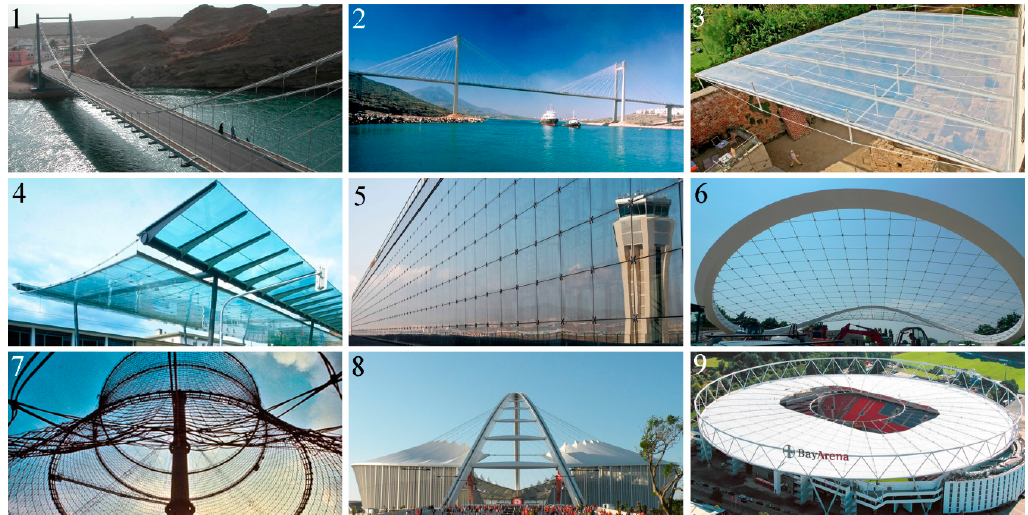
Figure 1. Typical modern cable structures with steel cables: ( 1 ) suspension bridge, Highway Bridge Khor al Batah, Oman (photo credit: STRABAG); ( 2 ) cable-stayed bridge, Evripos Bridge, Greece (photo credit: schlaich bergermann und partner); ( 3 ) cable truss roof, Annex Lutherhaus Roof, Germany (photo credit: Monika Nikolic); ( 4 ) cable suspension roof, Glass Canopy of Station Plaza Heilbronn, Germany (photo credit: schlaich bergermann und partner); ( 5 ) cable net facade, Facade Airport Málaga, Spain (photo credit: Roschmann); ( 6 ) saddle-shaped cable net, Canopy in Autostadt Wolfsburg, Germany (photo credit: schlaich bergermann und partner); ( 7 ) cable net tower, Dry Cooling Tower in Schmehausen near Hamm, Germany (photo credit: schlaich bergermann und partner); ( 8 ) arch tower cable supported roof, Moses Mabhida Stadium, South Africa (photo credit: schlaich bergermann und partner); and ( 9 ) spoked wheel cable roof, Bay Arena Leverkusen, Germany (photo credit: Bayer 04 Leverkusen Fußball GmbH).